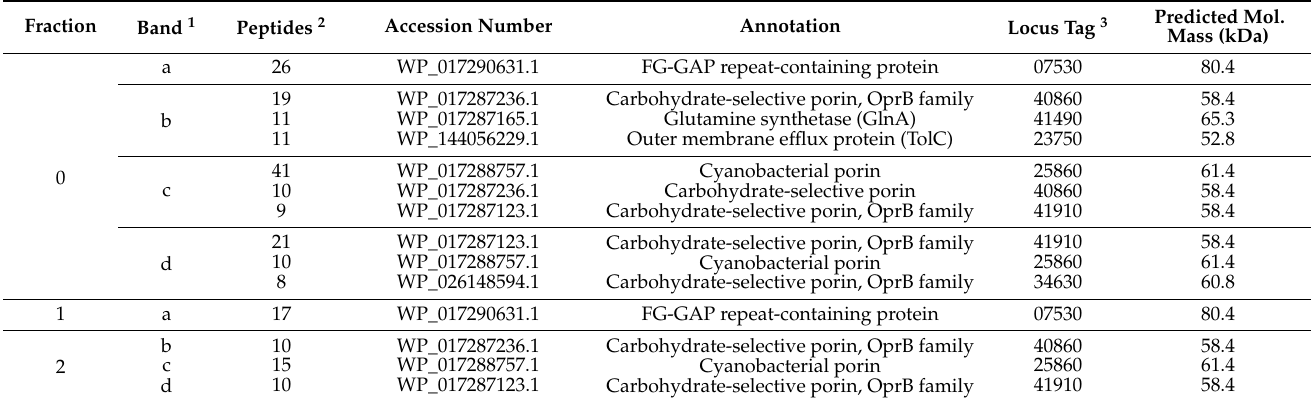
Table 1. Protein identification of the fractions from sucrose density gradient